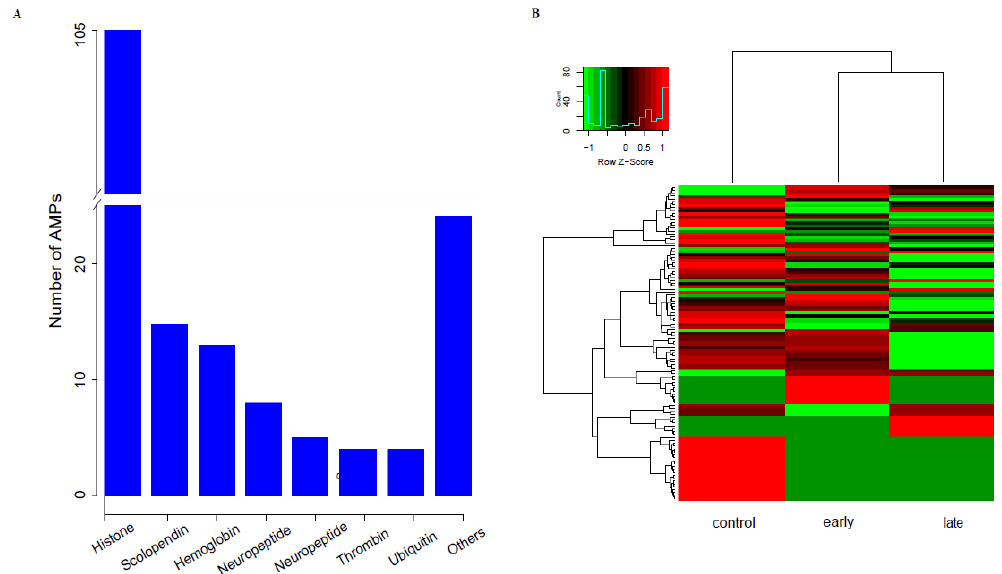
Figure 4. The summary of antimicrobial peptides (AMPs)/AMP precursors in Kanglang white minnow (KWM) in response to the Ich infections. ( A ) Confirmed peptides number hit against the gene set in KWM according to the different type of AMPs/AMP precursors (Others includes all other type that with only one or two confirmed peptides under that type). ( B ) Transcriptional variances of identified AMPs/AMP precursors in KWM in response to the Ich infections. Scale of the color bar represents fold changes of transcription levels in three groups.